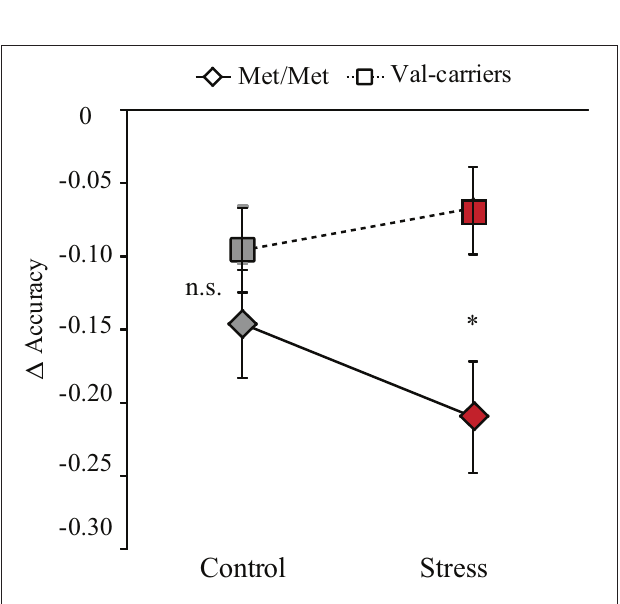
FIGURE 2 | Stress-by- COMT genotype interaction effect on WM performance. Difference of accuracy between 2- and 0-back tasks was plotted on the vertical axis as a function of control and stress conditions for two genotype groups ( COMT Met-homozygotes and Val-carriers). Note: ∗ p < 0 . 05; error bars in the graph represent standard error of